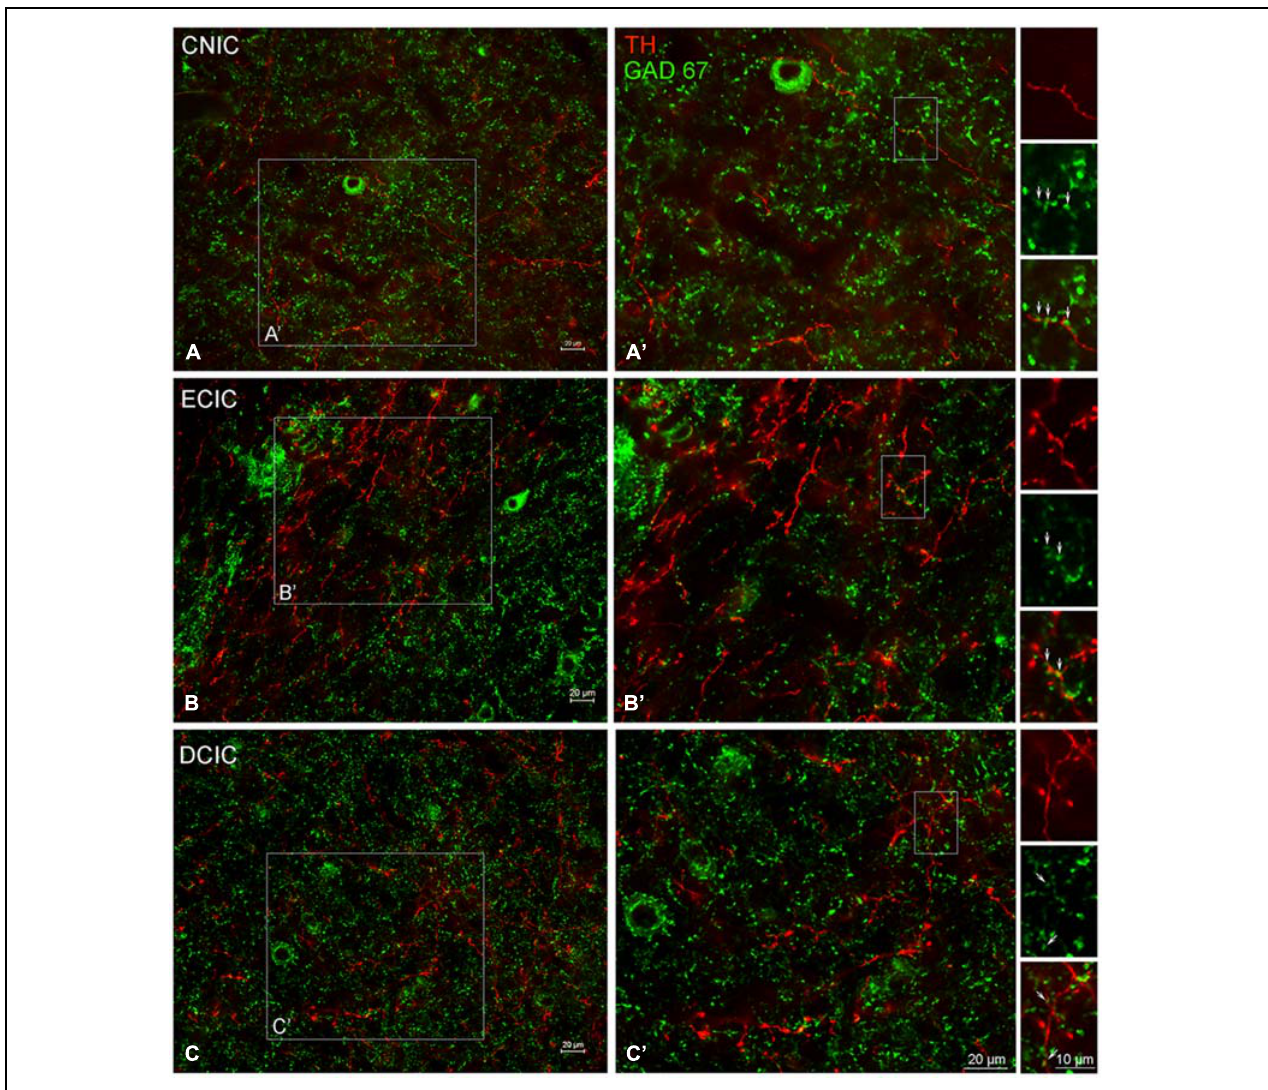
the IC (A–C) are in close contact with TH labeled terminals (A’,B’) . Arrows indicate TH labeled spines studded with GAD67 labeled